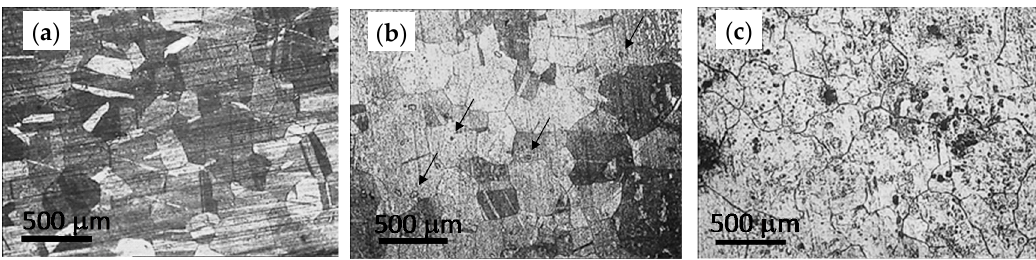
Figure 3. DRX diffractograms of the as-received copper: ( a ) samples 0, 1, 2 and 3; and ( b ) sample 4, with Cu 2 O peaks identified by *.